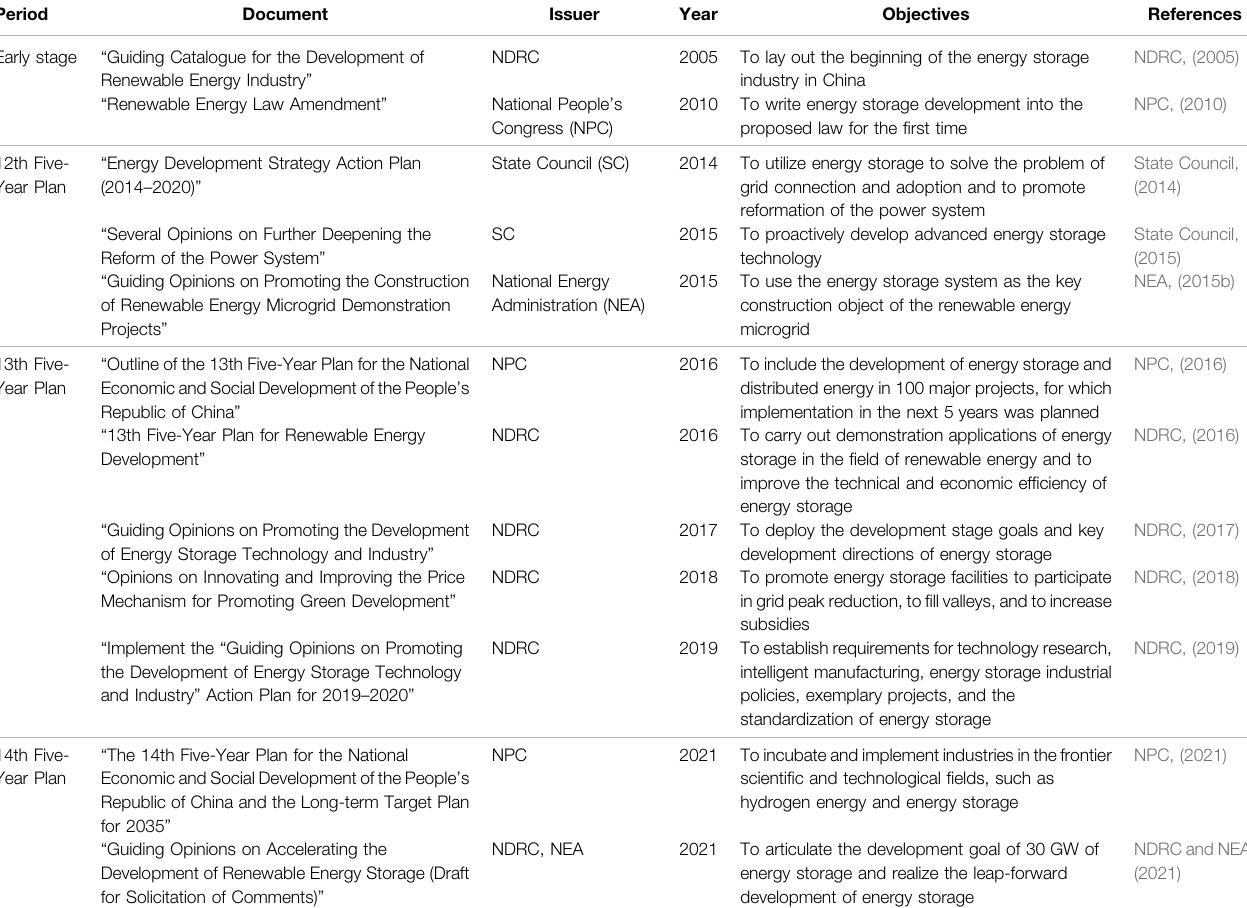
TABLE 1 | Policy of the energy storage industry in